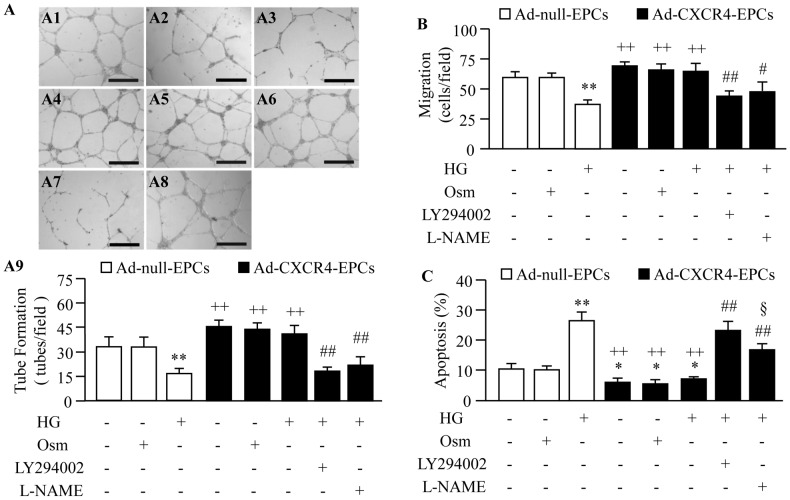
Ad-CXCR4 transfection protects EPCs from HG-induced dysfunction and apoptosis via activating Akt/eNOS pathways.Representative tube formation pictures (A1–A8) and summarized data (A9) in different treatment groups. A1: Ad-null-EPCs+Con; A2: Ad-null-EPCs+Osm; A3: Ad-null-EPCs+HG; A4: Ad-CXCR4-EPCs+Con; A5: Ad-CXCR4-EPCs+Osm; A6: Ad-CXCR4-EPCs+HG; A7: Ad-CXCR4-EPCs+HG+LY294002; A8: Ad-CXCR4-EPCs+HG+L-NAME. Scale bar: 600 µm. Summarized data on migration ability (B) and the percentage of EPC apoptosis (C) in different treatment groups. *P<0.05, **P<0.01 vs. Ad-null-EPCs or Ad-null-EPCs+Osm; ++
P<0.01 vs. HG+Ad-null-EPCs; #
P<0.05, ##
P<0.01 vs. HG+Ad-CXCR4-EPCs; §
P<0.05 vs. HG+Ad-CXCR4-EPCs+LY294002, n = 6/group. Con: control (basal medium); Osm: osmotic control; HG: high glucose medium; Ad-null-EPCs: EPCs transfected with Ad-null; Ad-CXCR4-EPCs: EPCs transfected with Ad-CXCR4.